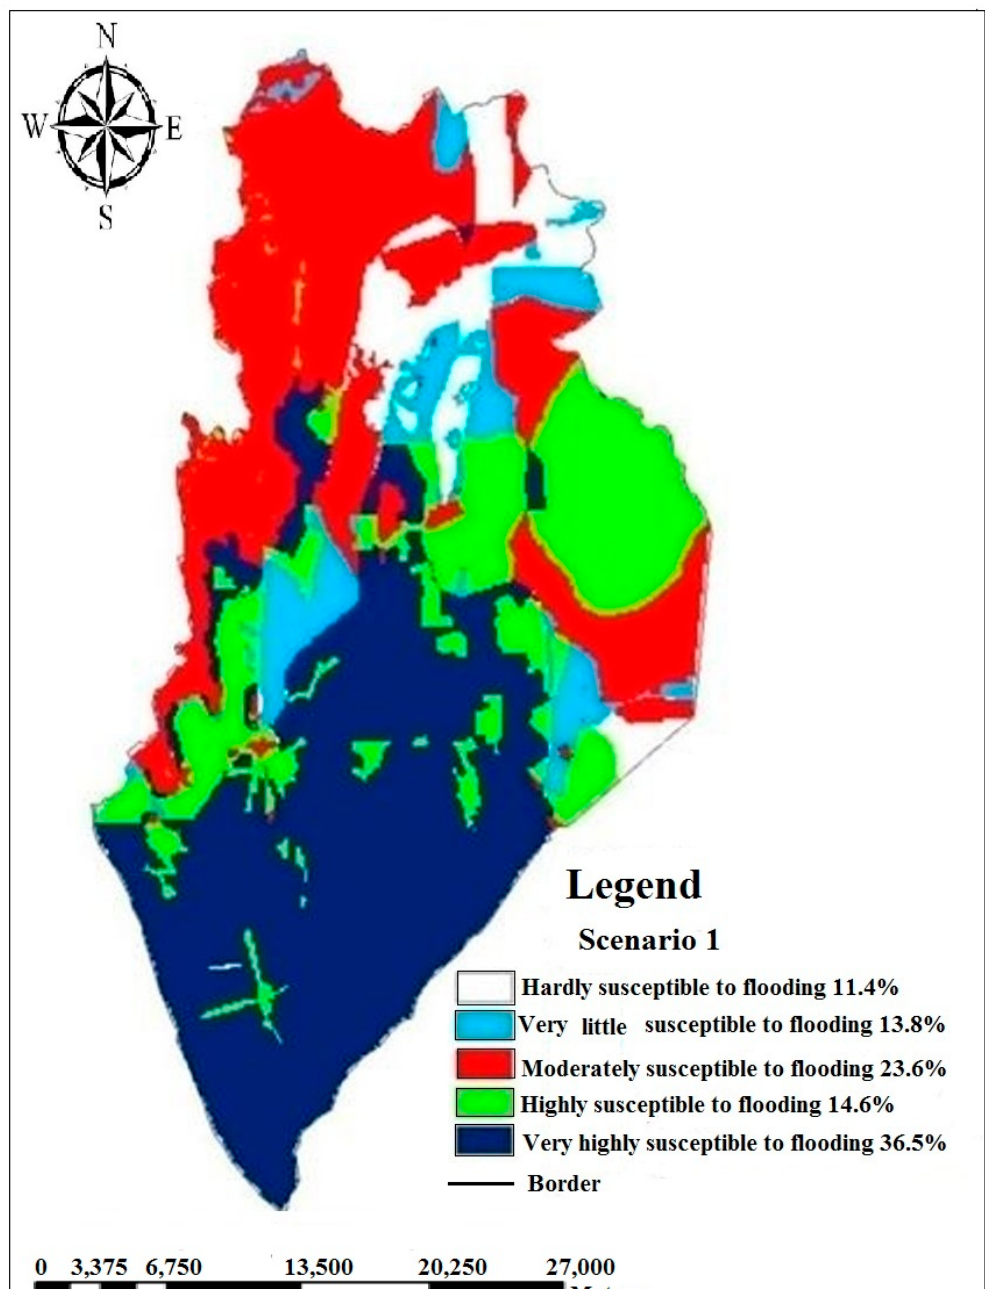
Figure A1. Importance of alluvium (Scenario 1).